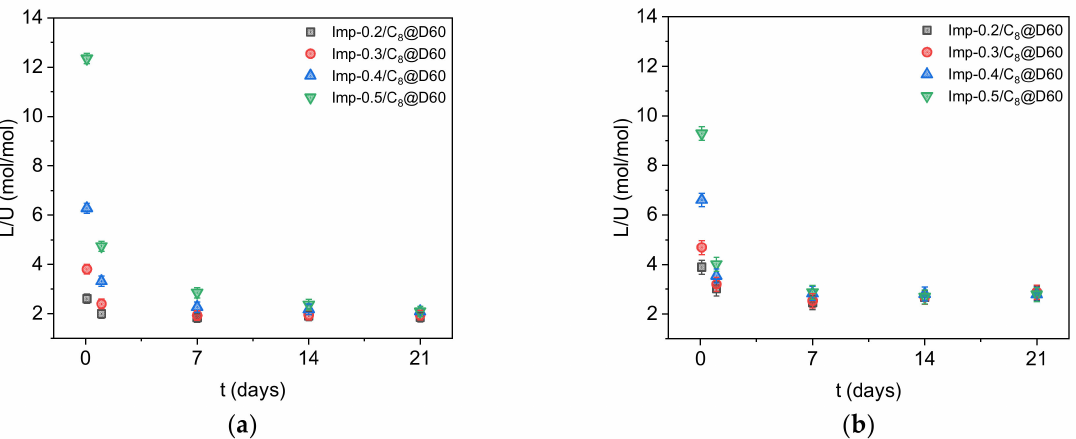
Figure 7. Ligand to uranium molar ratio of the four functionalized materials with different ligand concentrations after 2 h and 1, 7, 14 and 21 days in sulfuric acid solutions ([SO 4 ] 2 − /[U] = 900 mol/mol) ( a ) in the absence and ( b ) in the presence of competing cations (Fe and Mo). Table 3. Uranium extraction parameters of the functionalized silica materials.